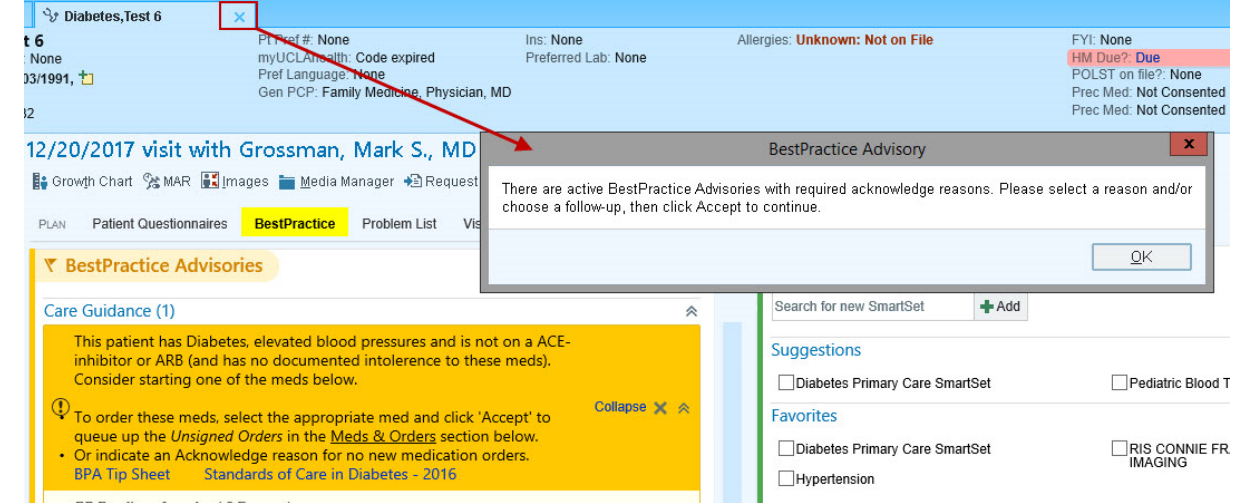
Figure 1. A “chart closure” hard stop prevents primary care providers from closing a patient’s chart without acting on the Best Practice Advisory